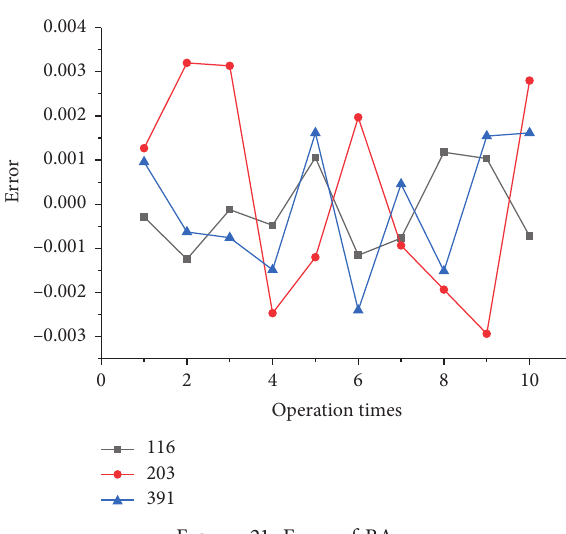
Figure 23: Error of IPSO.